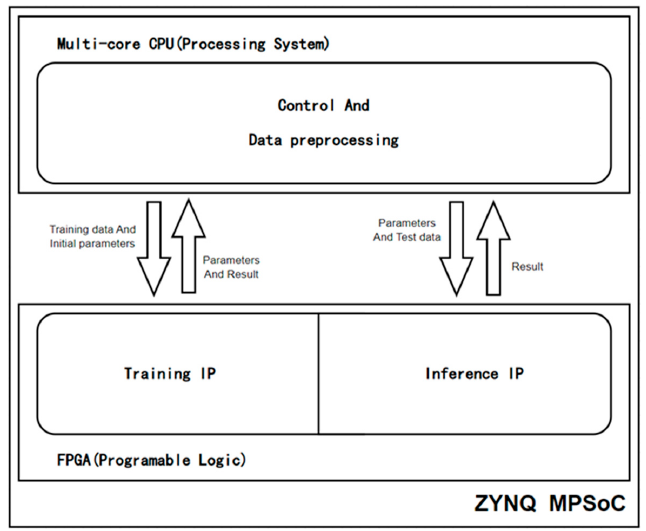
Figure 1. FPGA neural network training inference integrated implementation method.